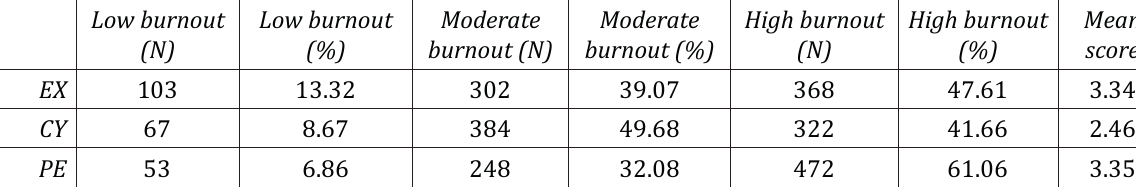
Table 2. The results of Maslach Burnout Inventory